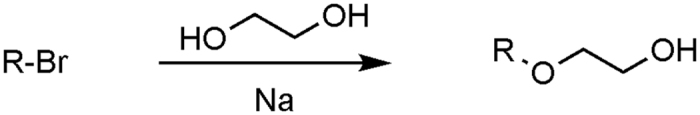
Synthetic scheme of 1-(2-alkyloxyl)-1-ethanol.R is a straight-chain hydrocarbon with 7-13 carbon atoms.